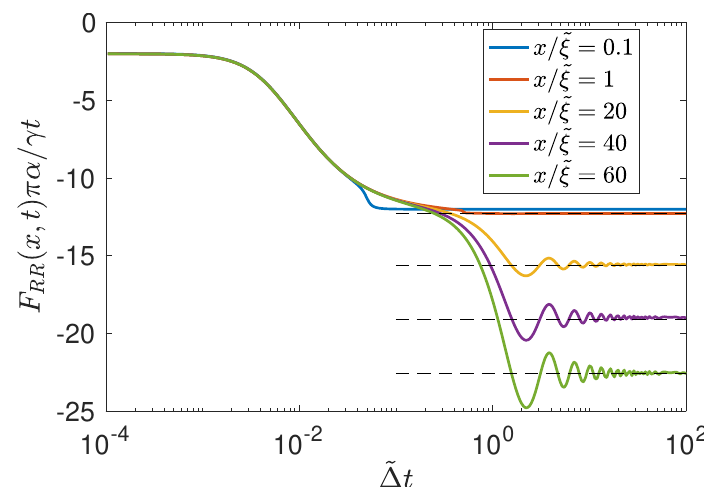
Figure 1: Normalized effective decay rate of correlations in the RR sector as a function of time at various distances for K = 0.3 and α/ ˜ ξ = 0.01. The curves are obtained by evaluating Eq. (20) numerically. They start from − 2 in our dimensionless units for short times and reach the x dependent asymptotic values (thin black dashed lines) from Eq. (22). In between, the crossover is described by Eq.